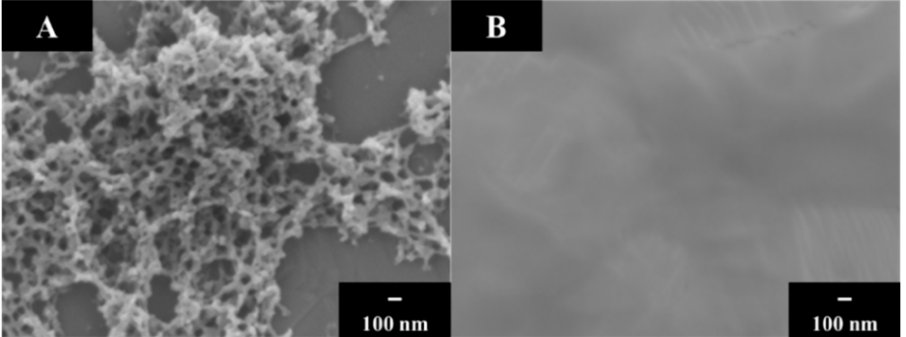
Figure 1. SEM images of PMMA coating: ( A ) as-deposited and room-temperature-dried, ( B ) annealed at 200 ◦